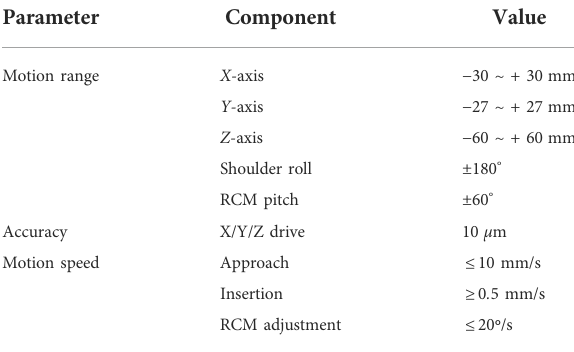
TABLE 1 Parameters of the multi-DOF dual-arm